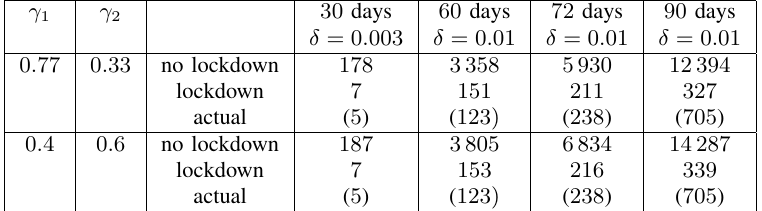
TABLE V: Comparison of deaths at different optimal